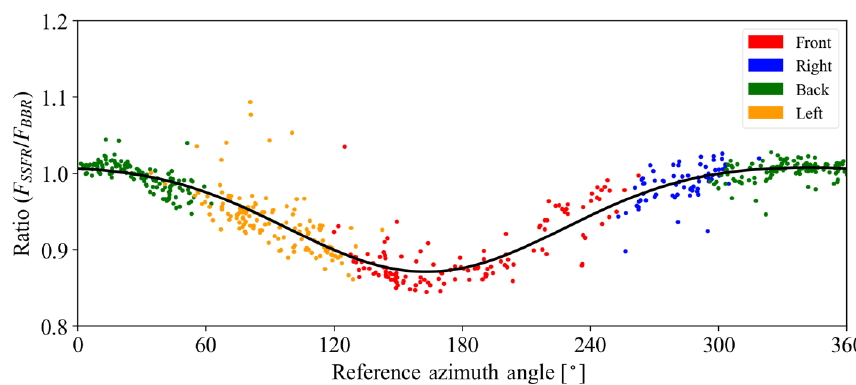
Figure B1. Ratio between spectrally integrated SSFR downwelling irradiance and broadband downwelling irradiance from BBR as a function of reference azimuth angle (solar azimuth position with respect to the sensor, 0 ◦ pointing north) during 01:00–01:36UTC on 3 October 2014. The relative positions of the sun with respect to the aircraft are indicated by different colors. The black curve is a fitted function using a second-order Fourier